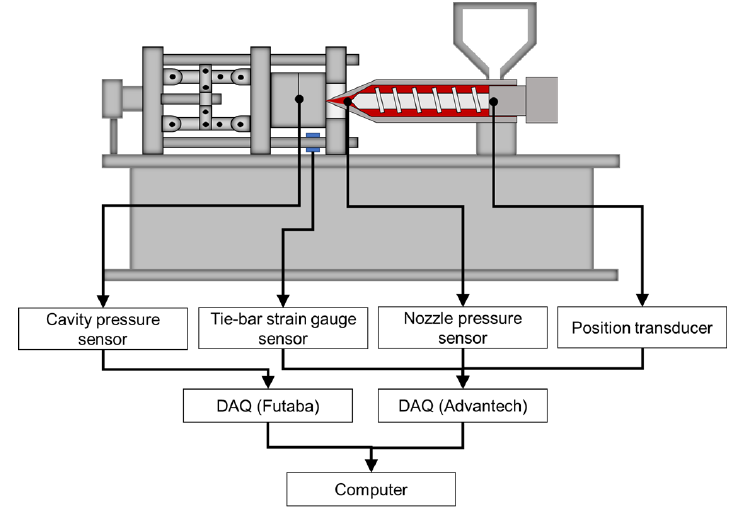
Figure 7. Experiment measurement system.